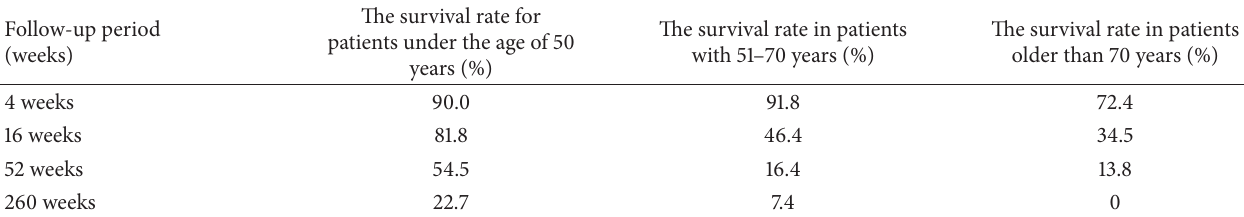
Table 3: Survival rates in patients with anaplastic thyroid cancer according to age.